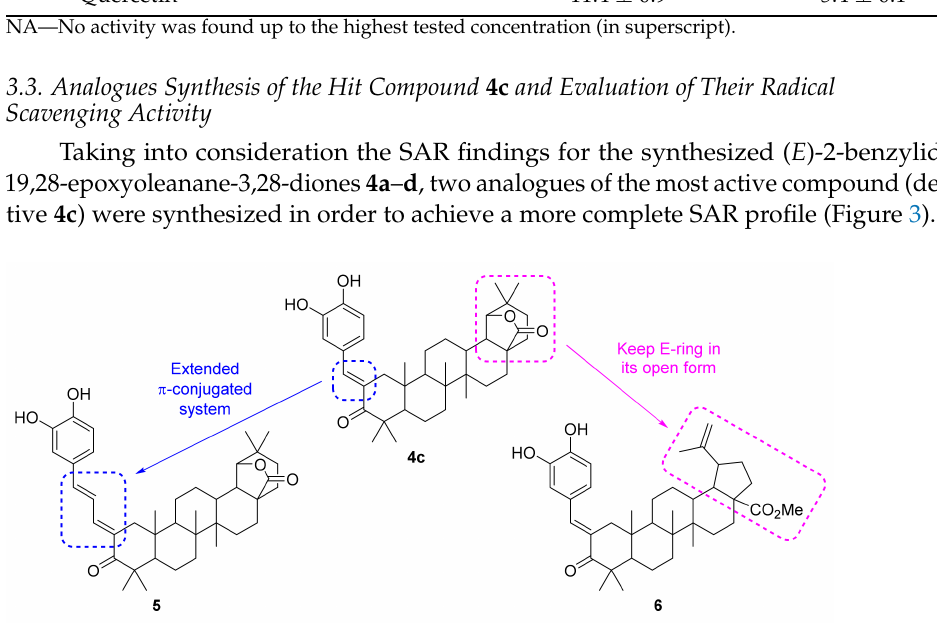
Figure 3. Analogue-based design of compounds 5 and 6